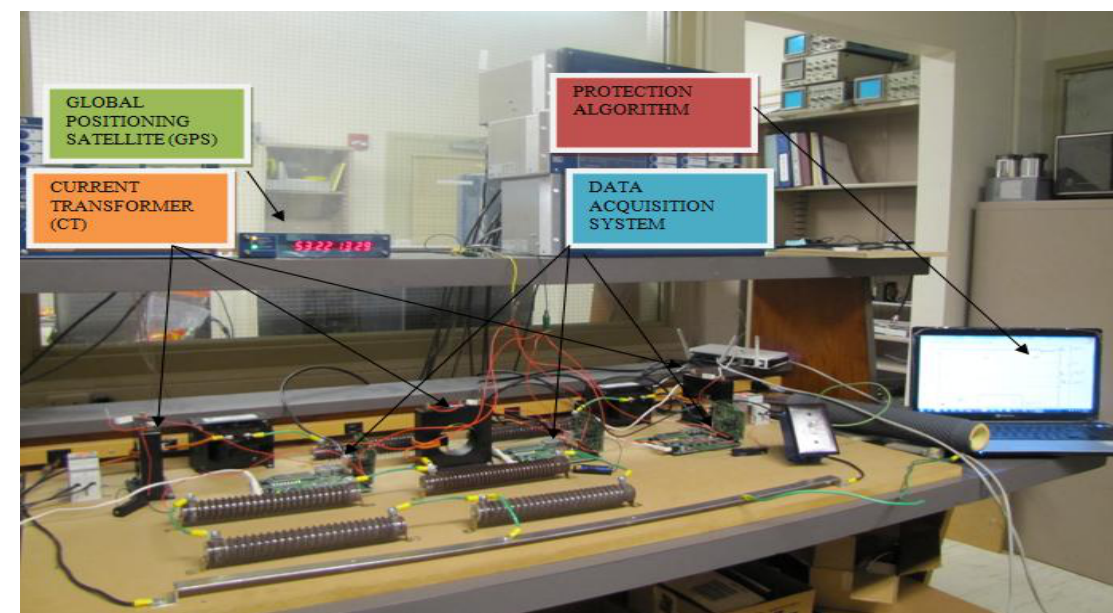
Figure 9 . The prototype of the protection system on the